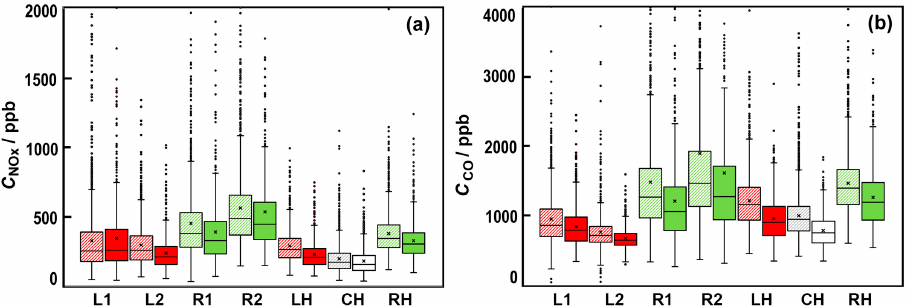
Figure 6. ( a ) The 1-min NOx concentrations when the 1-min average wind speed was <1.0 or ≥ 1.0 m · s − 1 in the 4-day campaign. Note: The hatched shading is for winds <1.0 m · s − 1 . ( b ) The average concentration of CO when 1-min average wind speed was <1.0 or ≥ 1.0 m − 1 in the 4-day campaign.